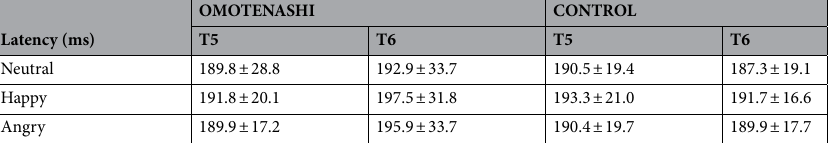
Table 4. Peak latency of N170 at T5 (left) and T6 (right) for Neutral, Happy, and Angry stimulus conditions in OMOTENASHI and CONTROL. Data are presented as the mean and standard deviation for each